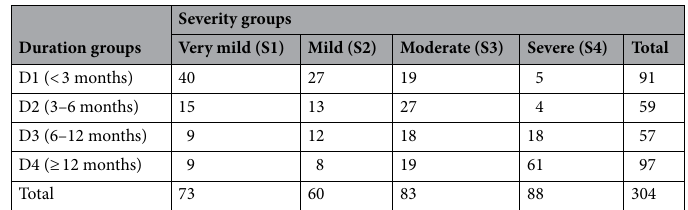
Table 2. Number of involved hands according to disease severity and symptom duration.